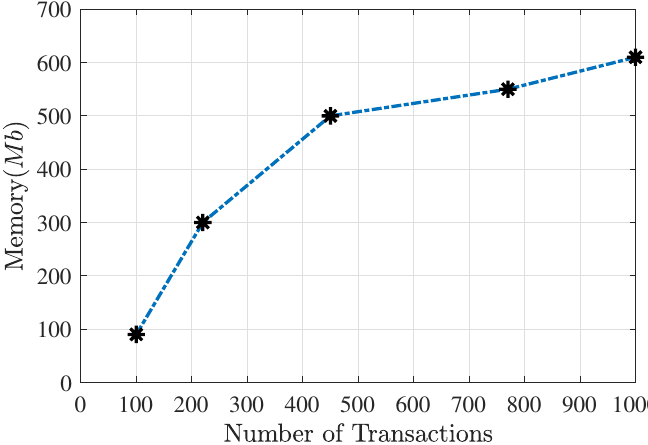
Figure 7. Used memory for broadcasting a number of transactions.